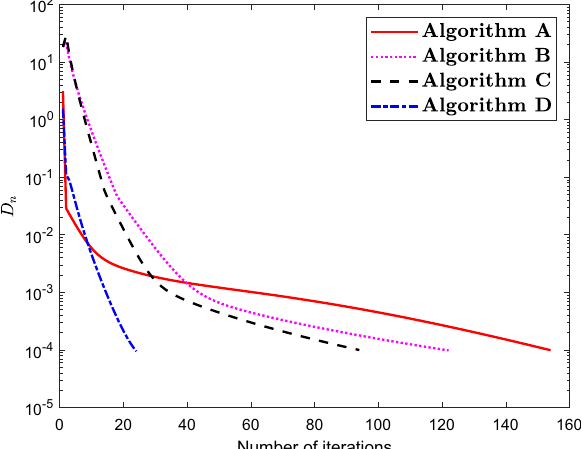
Fig. 2 Numerical illustration of Algorithm 1 with Algorithm 1 in [16] and Algorithm 3.1 in [1] and Algorithm 3.1 in [27] while m = 10 with q ∈ R m and